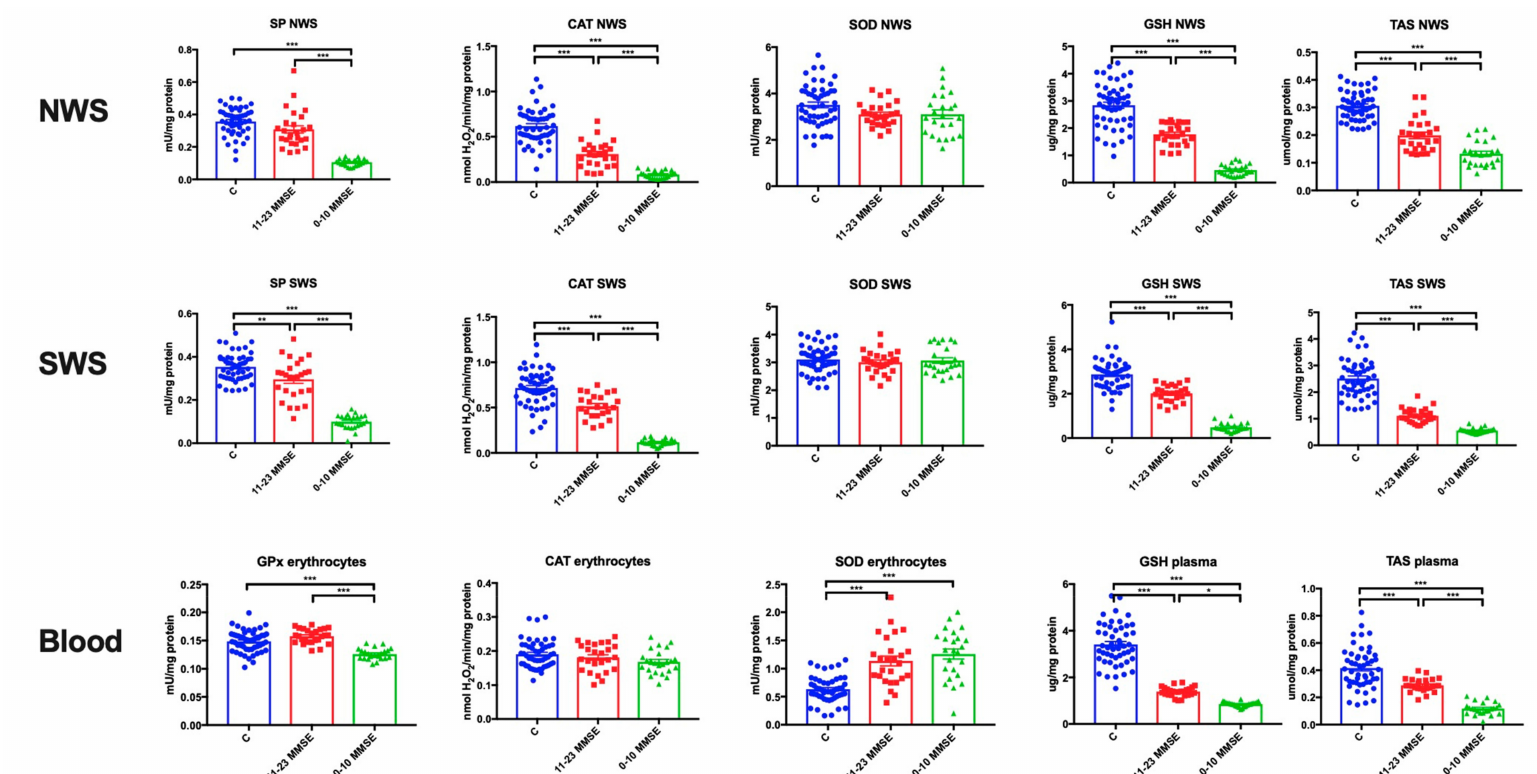
Figure 1. Antioxidant defence and redox homeostasis in the non-stimulated and stimulated saliva as well as erythrocytes and plasma of patients in di ff erent stages of dementia, and healthy controls. Abbreviations: C—the control; CAT—catalase; GPx—glutathione peroxidase; GSH—reduced glutathione; MMSE—Mini Mental State Examination; NWS—non-stimulated whole saliva; SP—salivary peroxidase; SOD—superoxide dismutase; SWS—stimulated whole saliva; TAS—total antioxidant status. * < 0.05, ** < 0.01, *** <